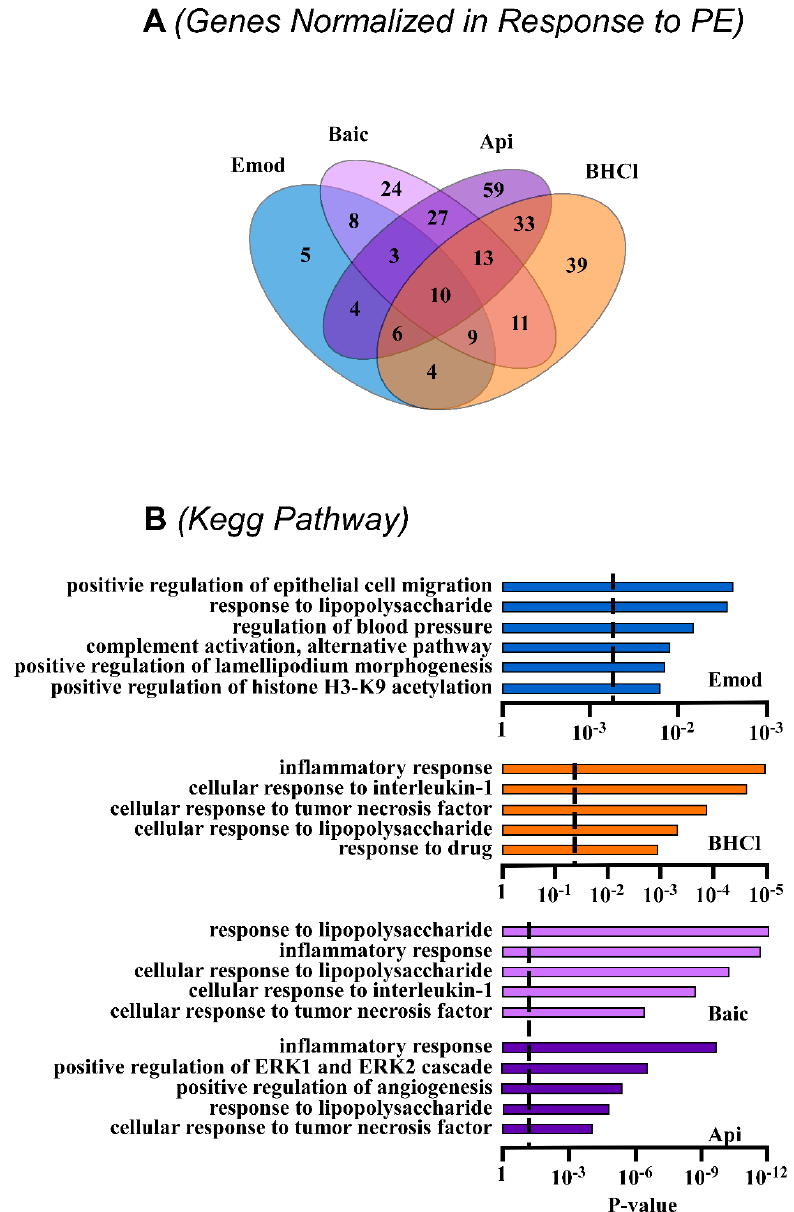
Figure 3. Phytochemicals regulate divergent and overlapping gene pathways in response to PE-induced cardiac hypertro- phy. NRVMs were stimulated to hypertrophy with phenylephrine (PE; 10 µM) in the absence or presence of vehicle control or phytochemicals (Apigenin (Api), Baicalein (Bac), berberine hydrochloride (BHCL), Emodin (Emod), Luteolin (Lut), or quercetin dehydrate (QD); All compounds were used at 10 µM) for 48 h. RNA was isolated and sequenced with the NEXT- Seq 500. Differential gene expression was visualized via heatmap and the expression level was scaled for each gene. Ad- ditional information for each gene can be found in Supplemental Table S1.